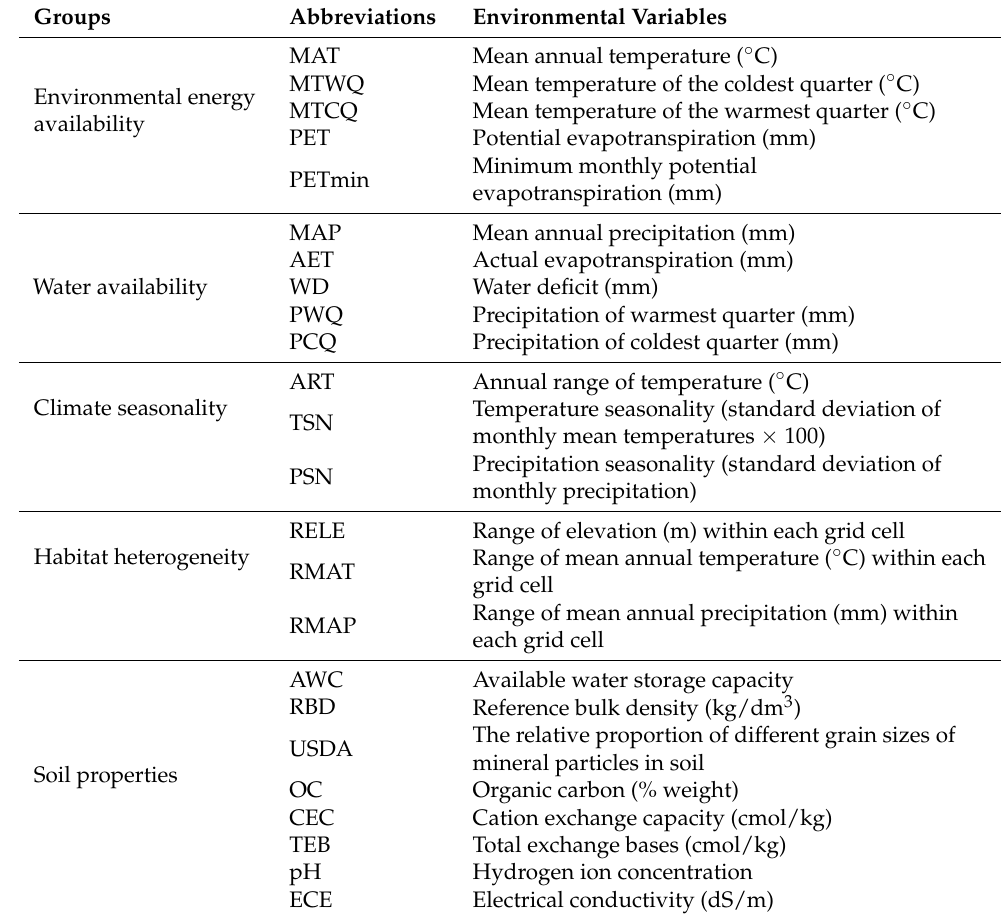
Table 1. Environment variables and their abbreviations used in the analyses.